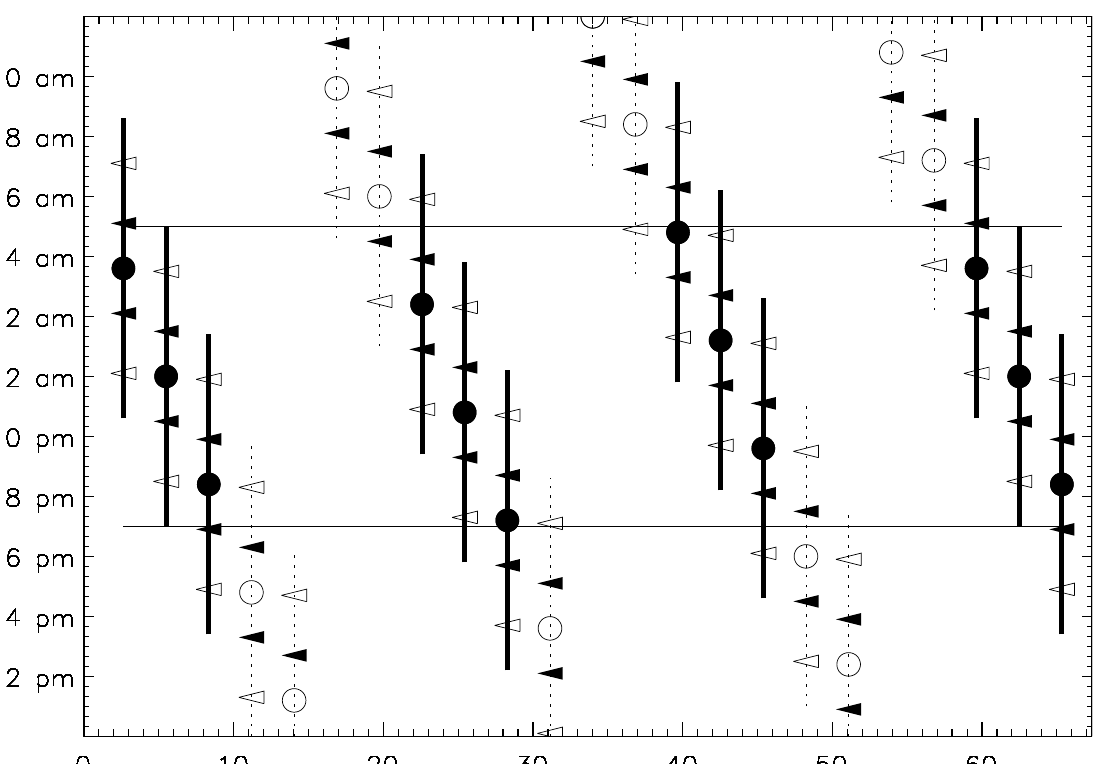
Fig 14. Eclipses of Algol with P A = 2.85 days. The horizontal continuous lines show the beginnings and ends of 10 hours long nights. The filled and open circles denote mid eclipse epochs occurring inside and outside such nights. The T A1 = 10 hour time intervals of eclipses are denoted with thick continuous or thin dashed lines. The tilted open and closed triangles show the T A2 = 7 and T A3 = 3 hour